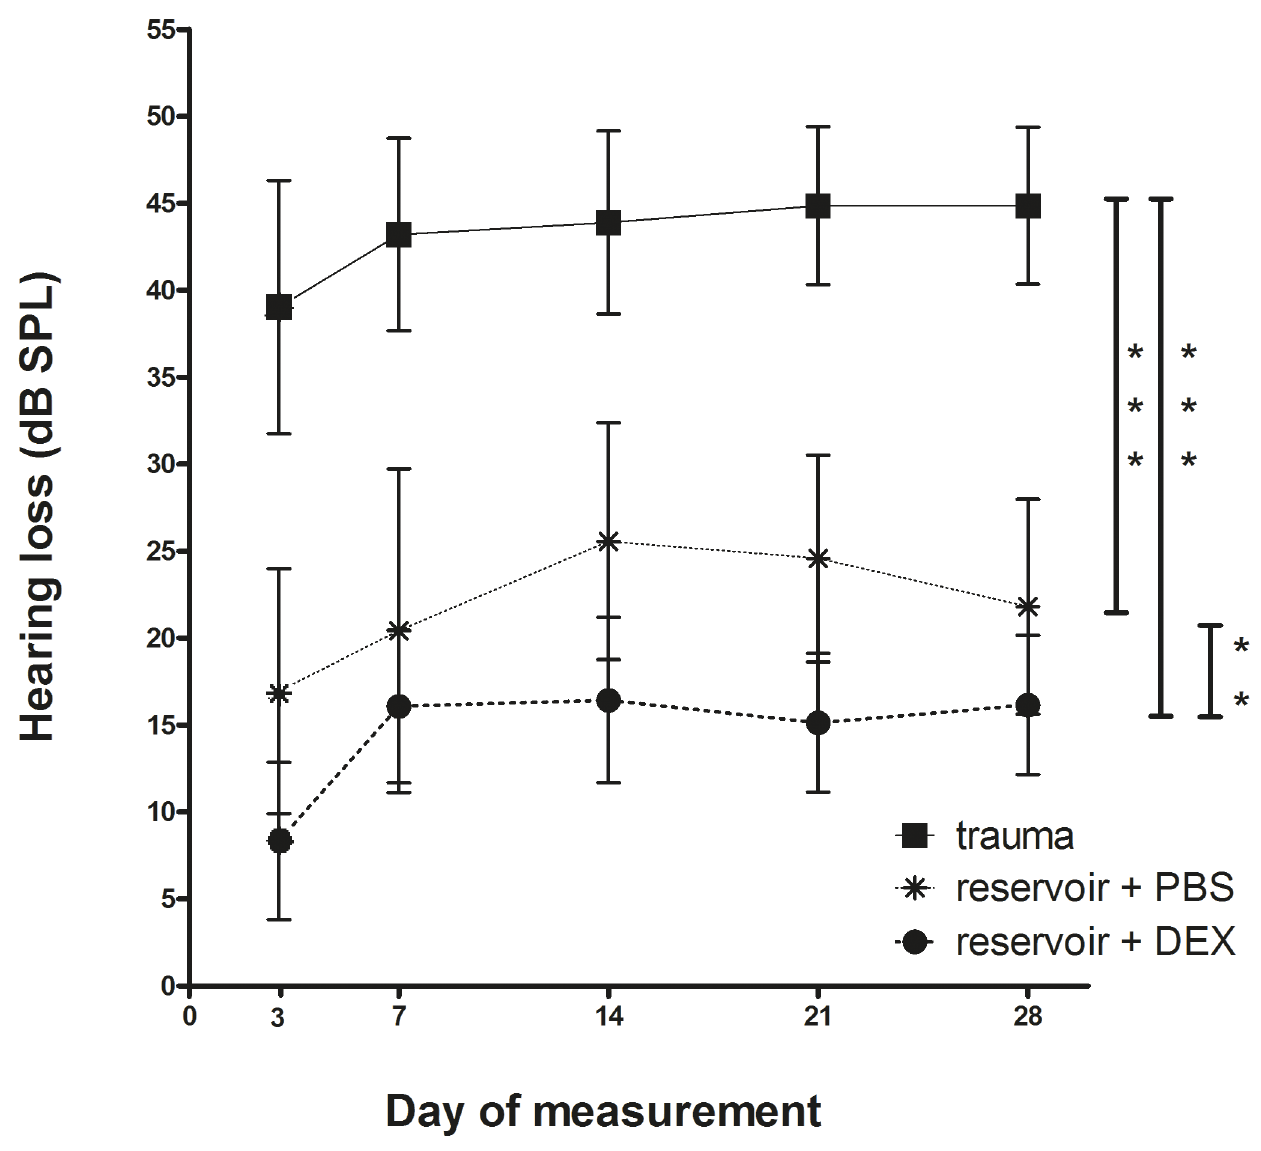
Figure 3. Mean and SEM of hearing loss (difference between the experimental days hearing threshold and hearing threshold before implantation) development from day 3 to day 28 for all experimental groups. Cochleae of the trauma group (n=12) suffered from highest hearing loss compared to all other experimental groups. Additionally, individuals implanted with a PBS releasing reservoir (n=12) lost hearing more significantly compared to the group having been implanted with the DEX filled reservoir (n=14). The statistical differences using ANOVA test examined on experimental day 28 are plotted at the right side of the graph, demonstrating, that the reservoir + DEX treatment resulted in the significantly best hearing thresholds. (**=p , 0.01; ***=p ,